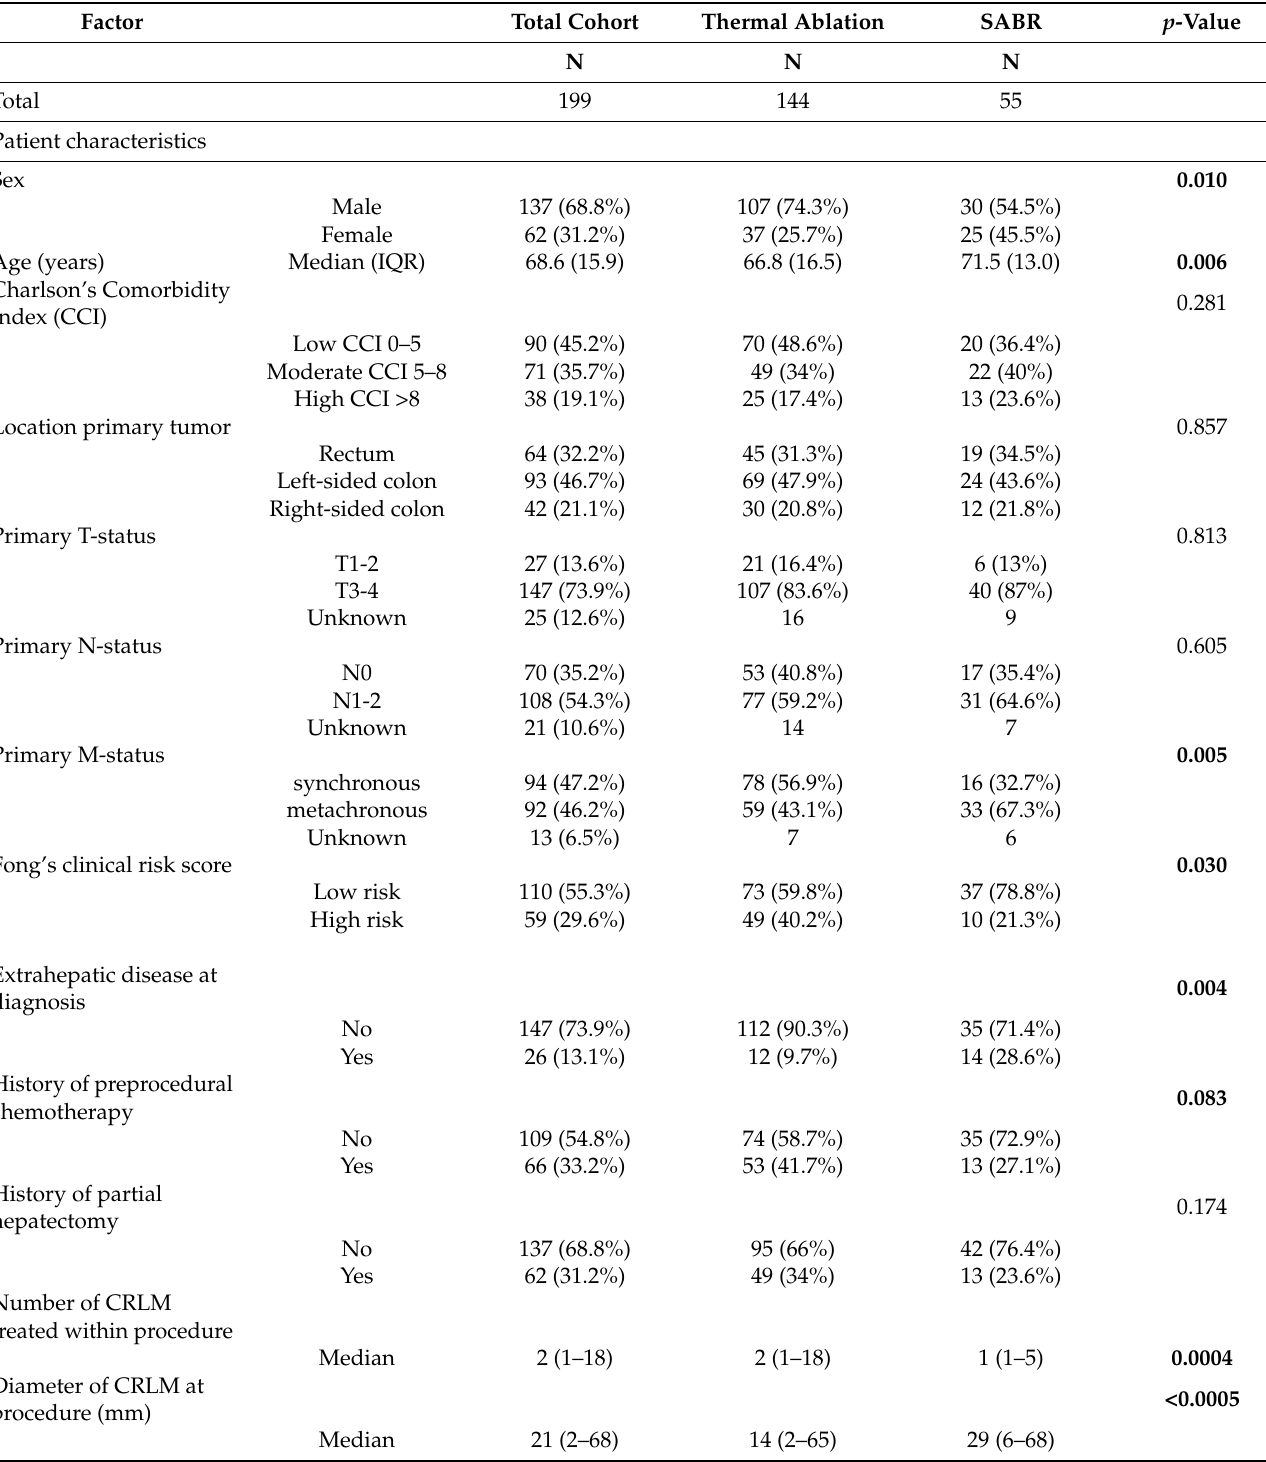
Table 1. Baseline characteristics of CRLM patients treated with thermal ablation or stereotactic ablative radiotherapy